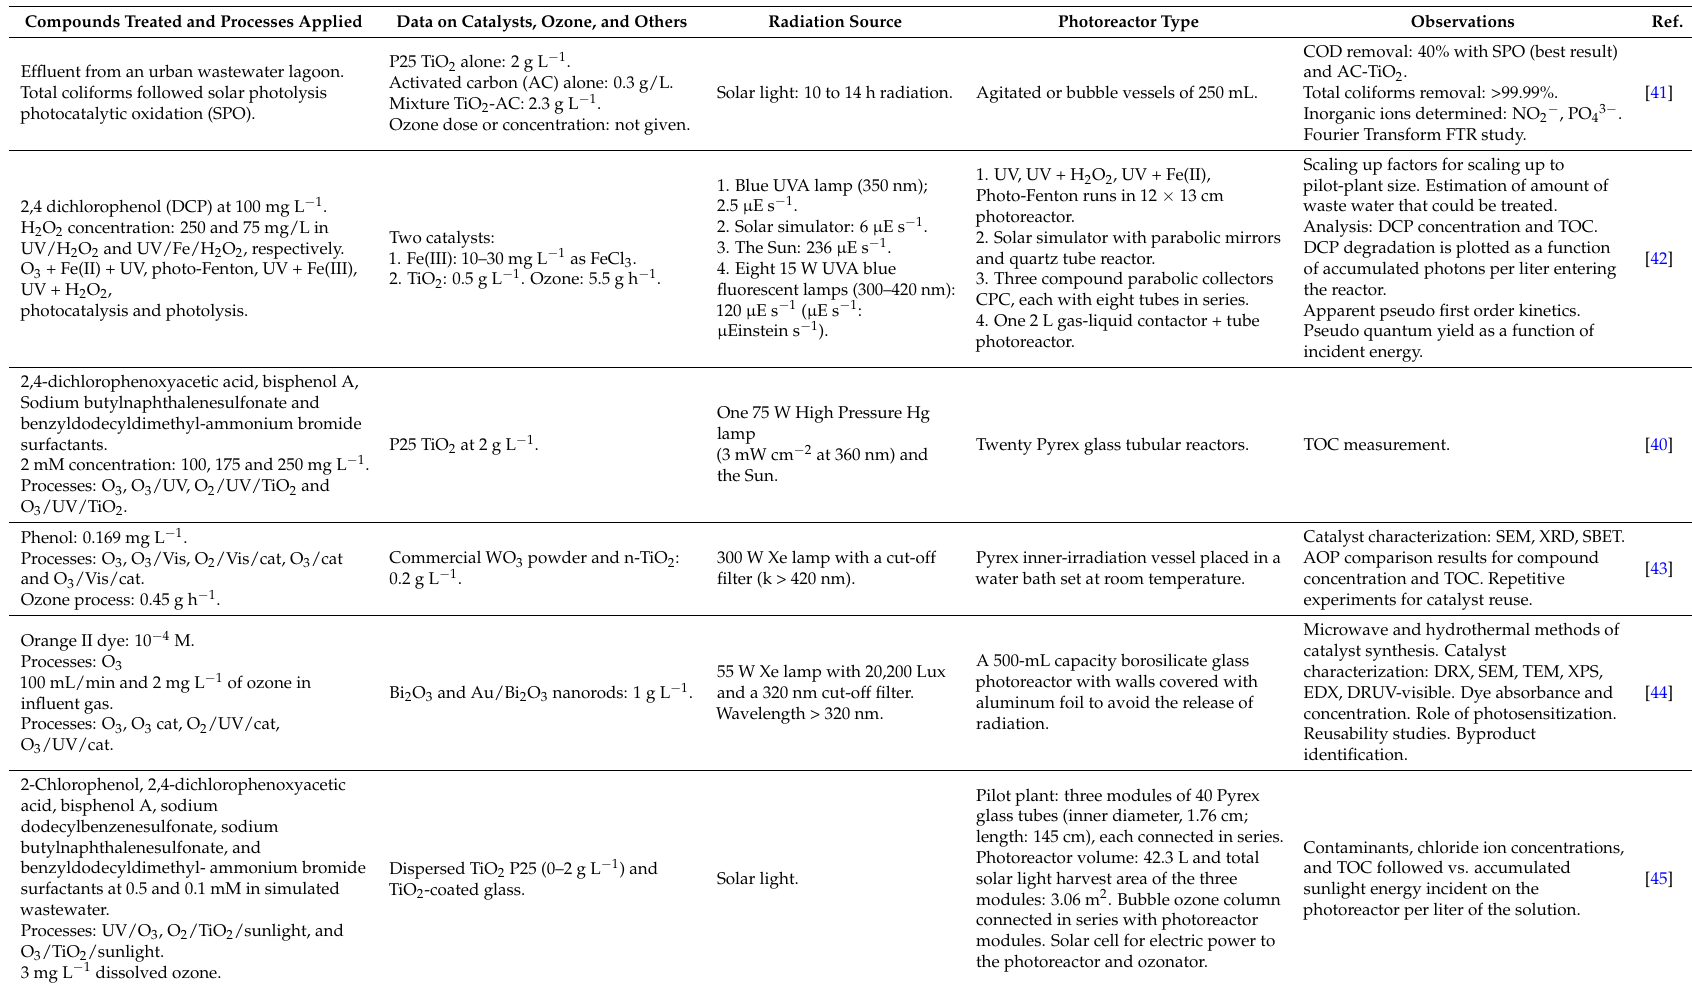
Table 2. Research articles published so far on solar or UVA-Visible light photocatalytic ozonation of water contaminants a . Compounds Treated and Processes Applied Data on Catalysts, Ozone, and Others Radiation Source Photoreactor Type Observations Ref. Effluent from an urban wastewater lagoon. Total coliforms followed solar photolysis photocatalytic oxidation